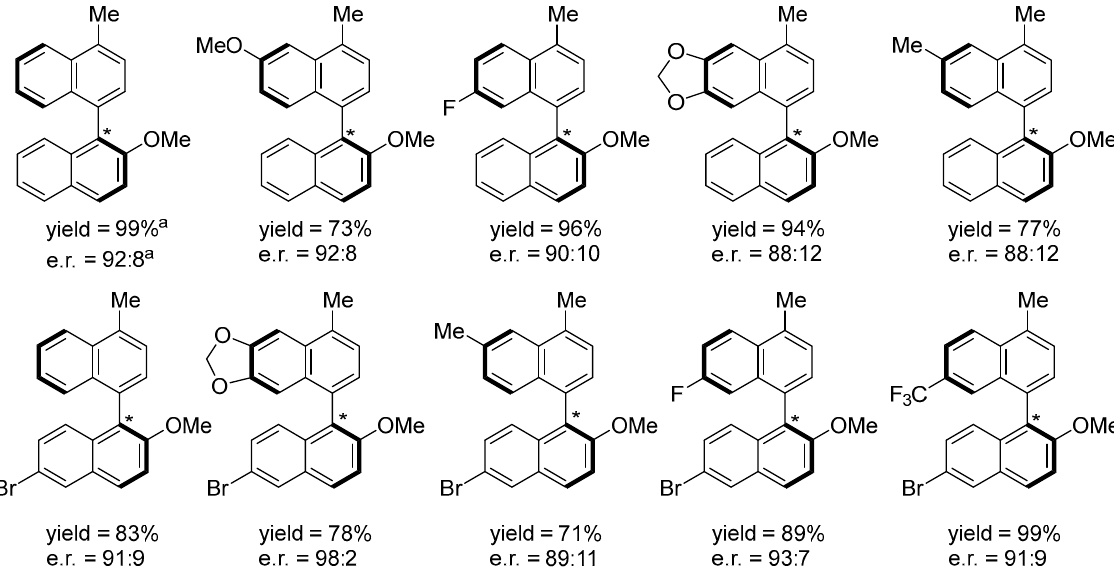
Figure 7. The scope of synthesized binaphthyl atropisomers.